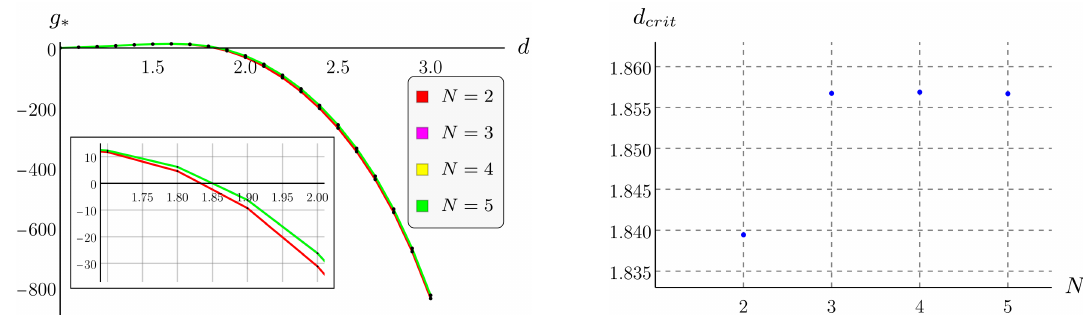
Figure 8 . Position of the g ∗ -coordinate of the NGFP (left panel) and critical dimension d crit as functions of the truncation order N . For N > 2 , the curves describing the variation of the g coordinate of the NGFP/QFP overlap and are almost indistinguishable. Accordingly, for N > 2 the value of the critical dimension d does not undergo significant crit